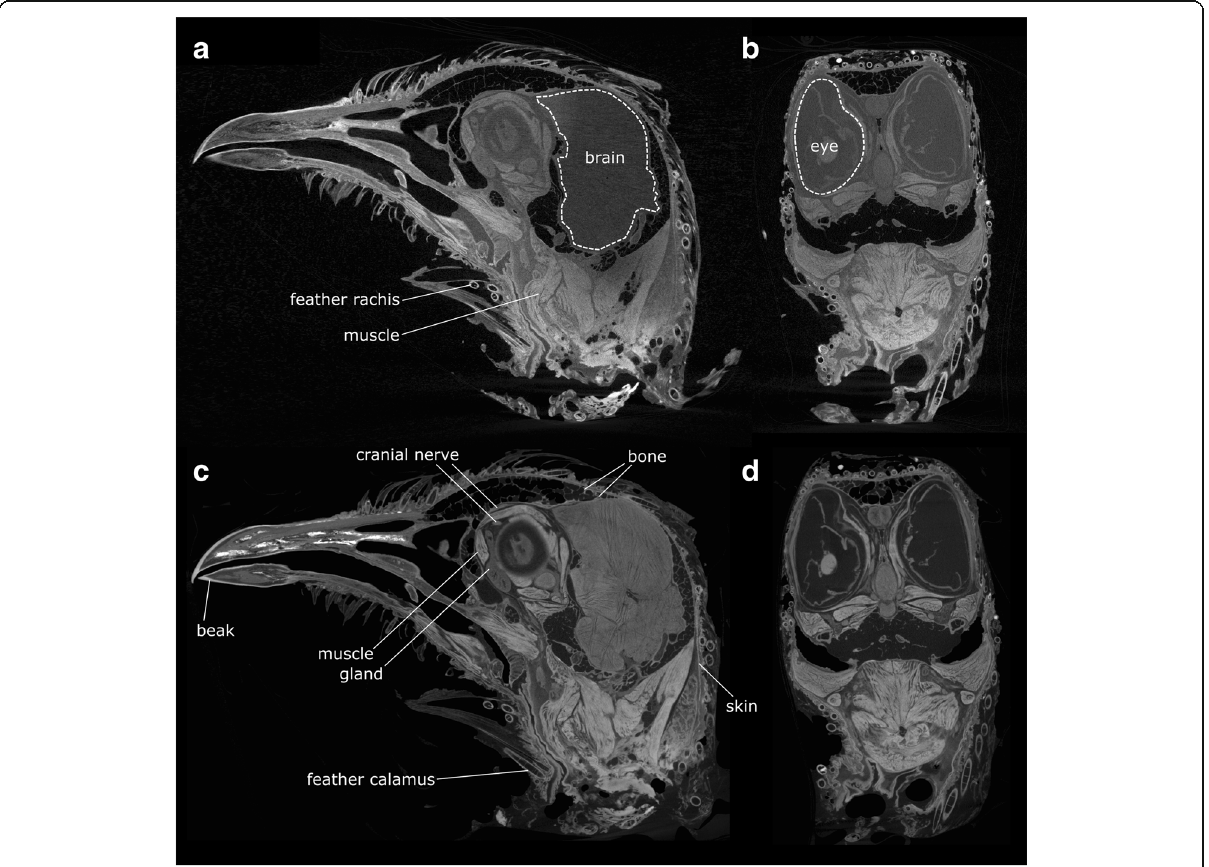
Fig. 1 Cross-sections through the Computed Tomography dataset of the iodine stained head of Columba livia . a , b , dataset 2, c , d , dataset 3. a 499 of 879 (parasagittal plane, yz). b 1065 of 1678 (coronal plane, xz). c 387 of 667 (parasagital plane, yz). d 1026 of 1515 (coronal plane,